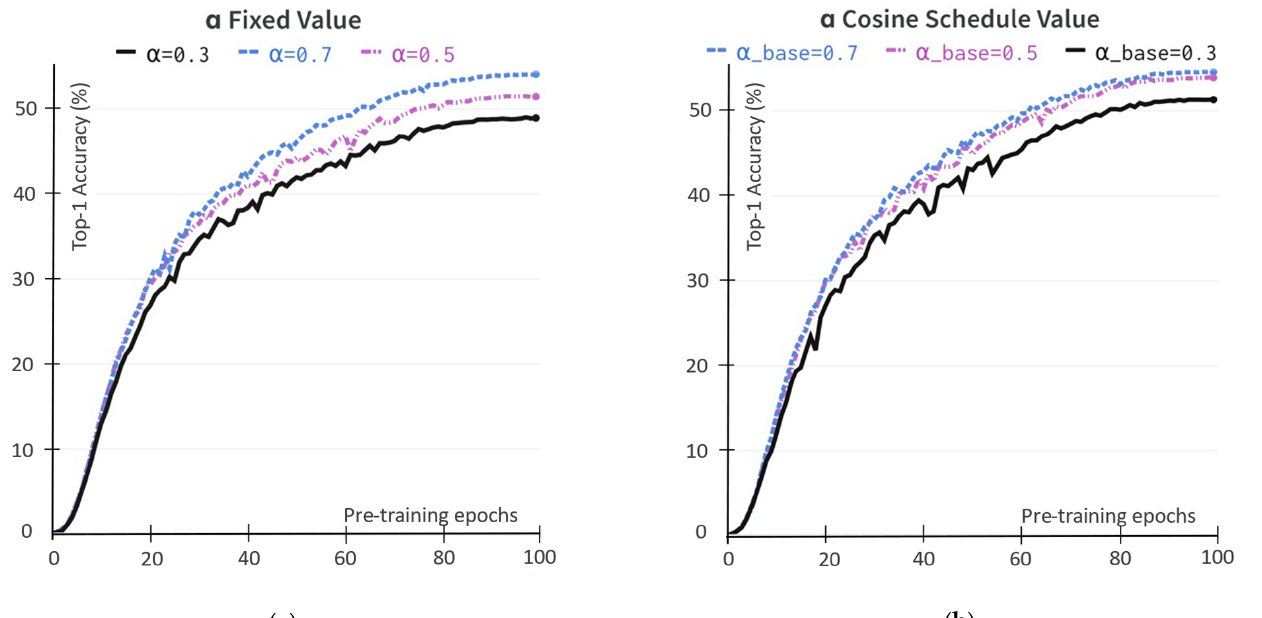
Figure 4. The impact of weighting coefficient α value to the obtained representation during the self-supervised pretraining stage with the ResNet-50 backbone. The evaluation during pretraining uses the ImageNet linear evaluation protocol in Top-1 accuracy (in %). ( a ) The α value is the fixed value; ( b ) The α value follows the cosine function scheduler.